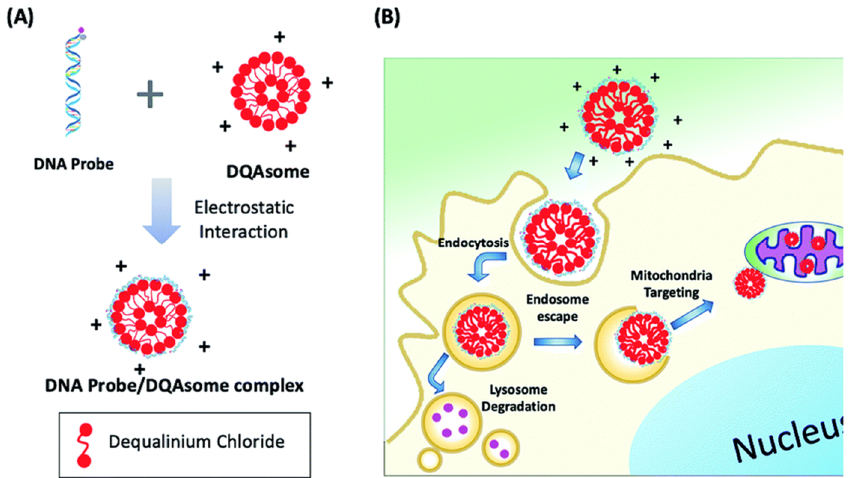
Figure 6. ( A ) Aptamer/DQAsome-based mitochondrion-targeted probe ( 28 ) and schematic of DNA probe/DQAsome complex formulation. ( B ) Schematic depiction of targeted delivery of DNA probe/DQAsomes to mitochondria. Reprinted with permission from ref. [65]—Published by The Royal Society of Chemistry.